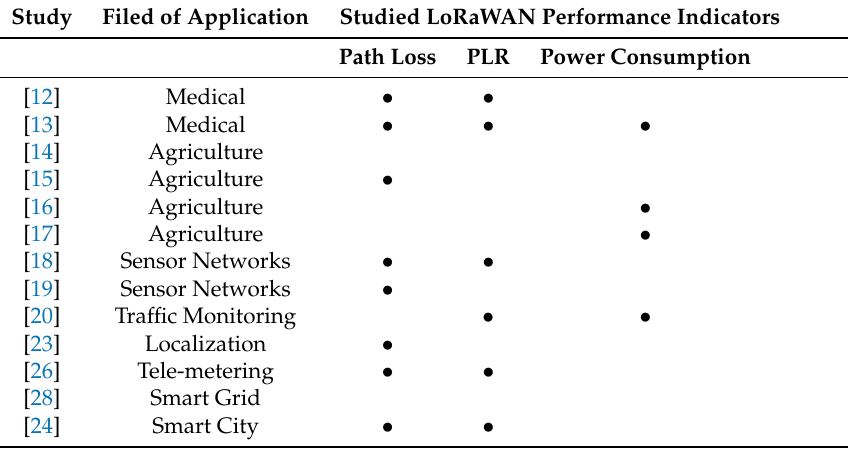
Table 2. LoRaWAN applications.